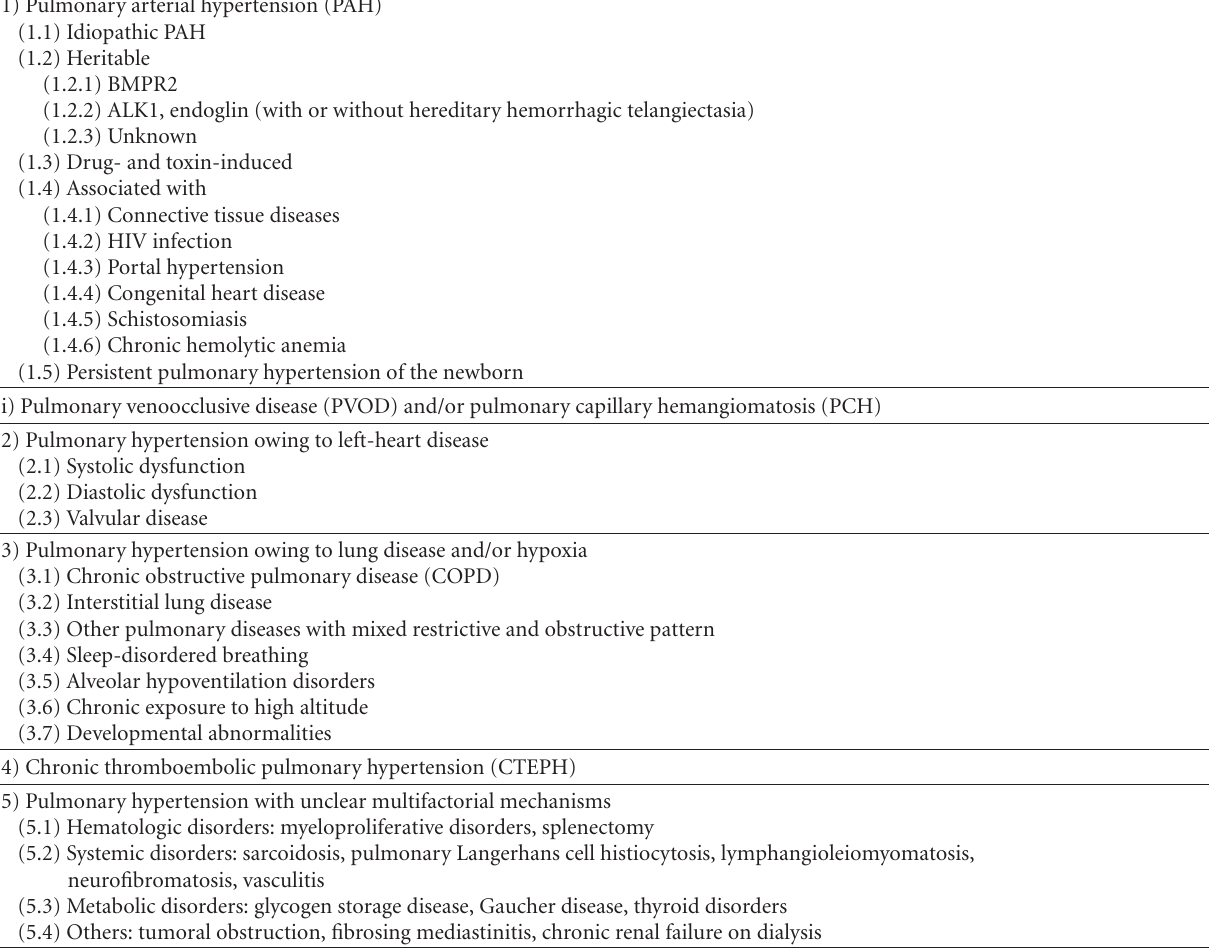
Table 1: Updated clinical classification of pulmonary hypertension (Dana Point, 2008)